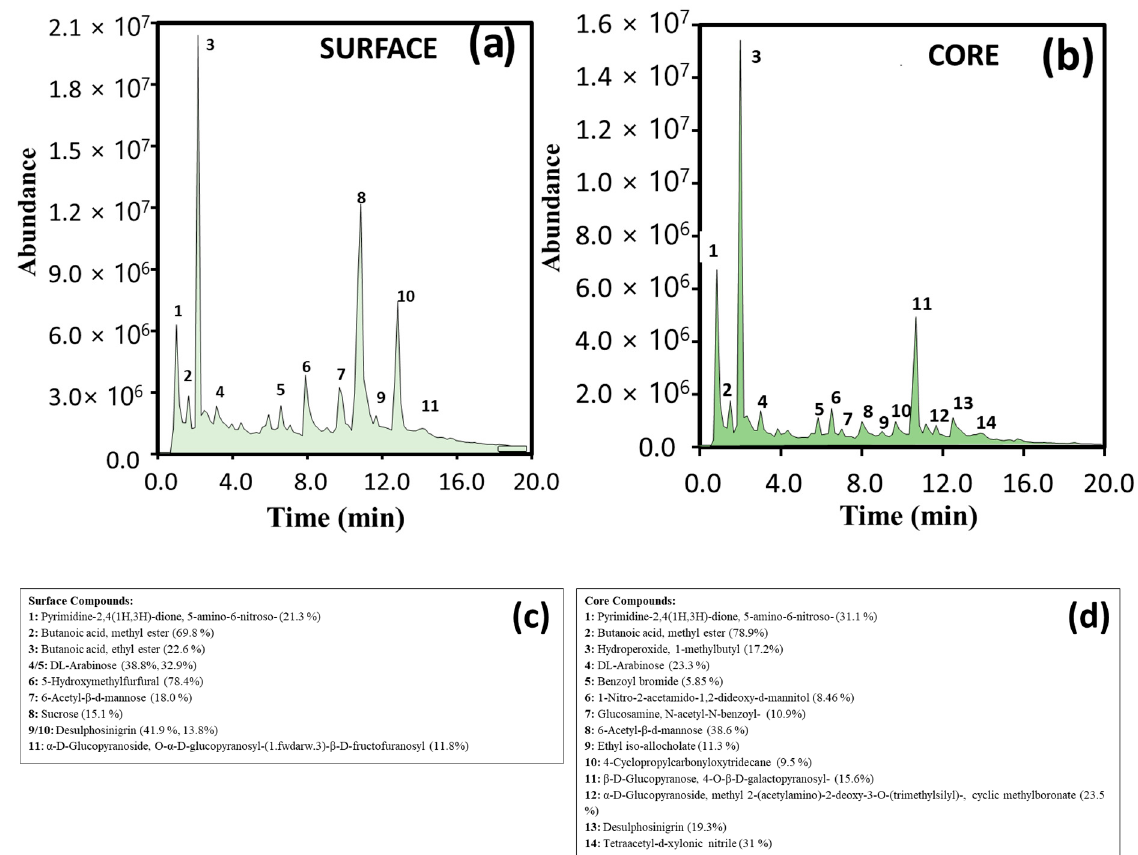
Figure 9. Total ion chromatograms (TICs) of GC-MS analysis of ( a ) kiwi surface and ( b ) kiwi core taken following SPME using a PANI@CNT/CNC SPME MN. Associated list of compounds found within ( c ) kiwi surface and ( d ) kiwi core deduced using the NIST library database.